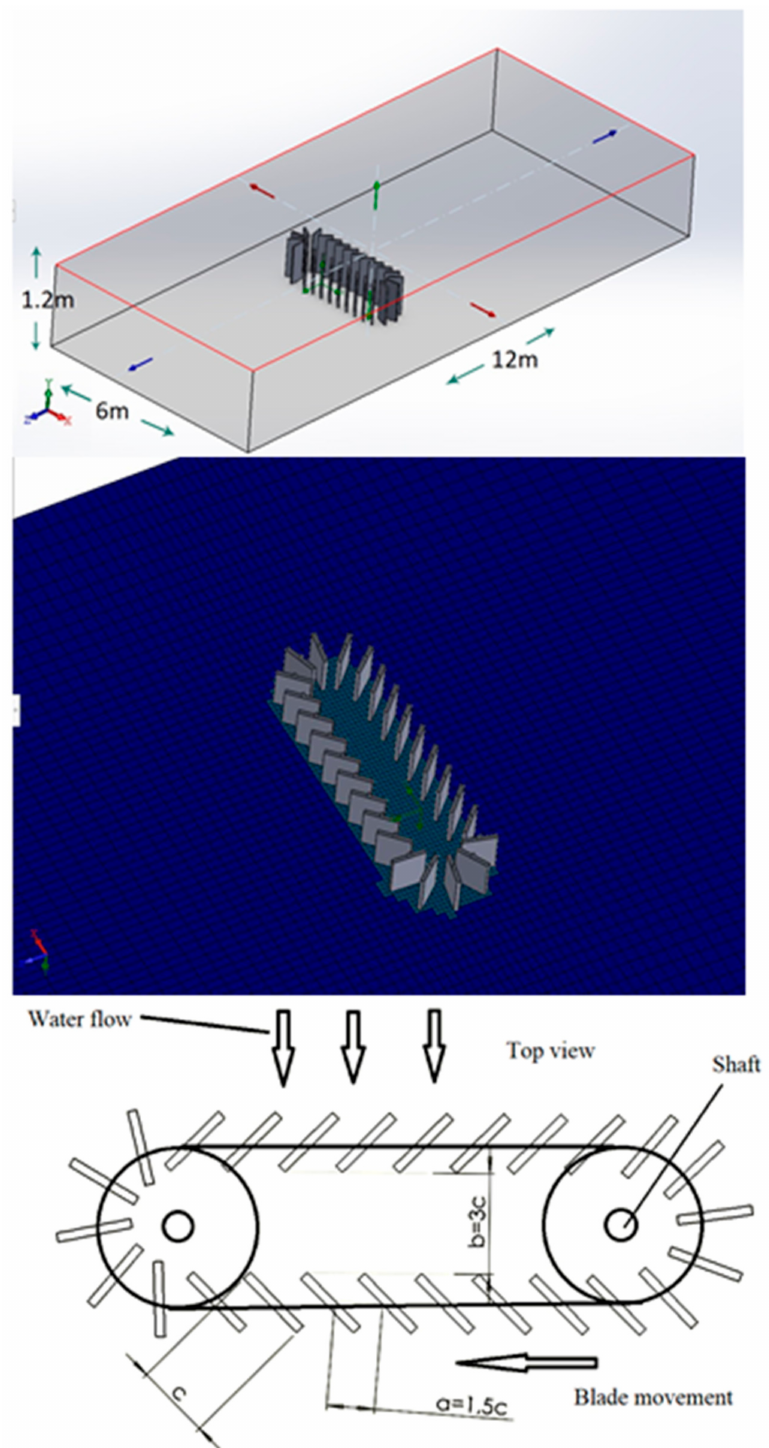
Figure 11. The domain for modelling: mesh Nx-100, Ny-21, Nz-123, where N is number of